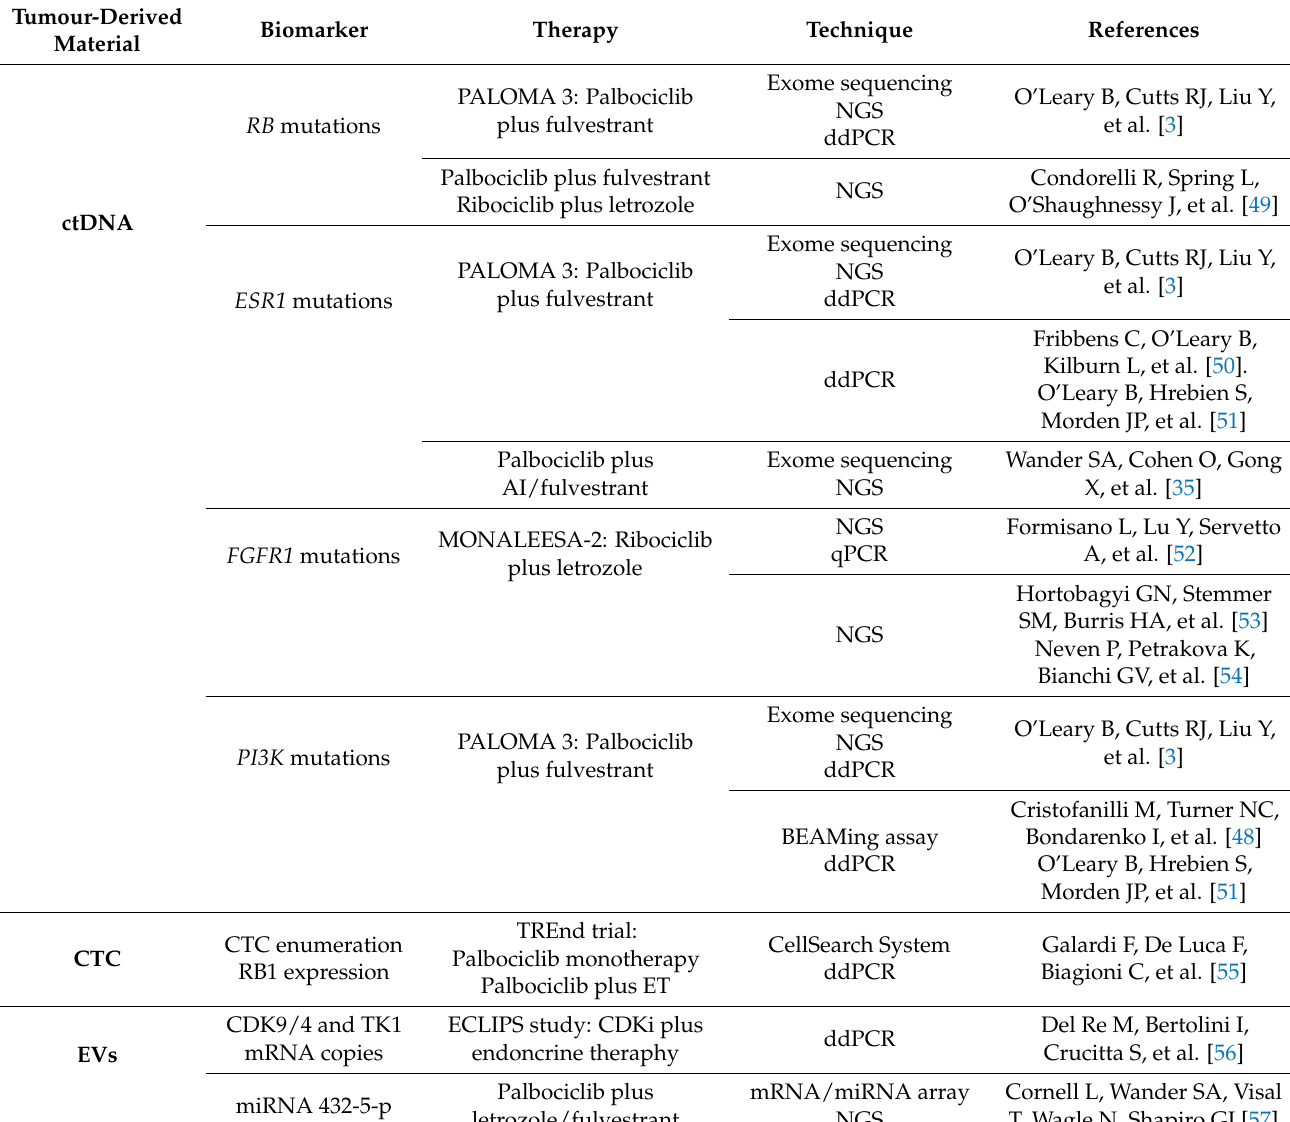
Table 1. Summary of the literature review based on the analysis of tumour-derived material from HR+/HER2- advanced breast cancer patients using liquid biopsy. (NGS: Next Generation Sequencing, ddPCR: droplet-digital PCR,